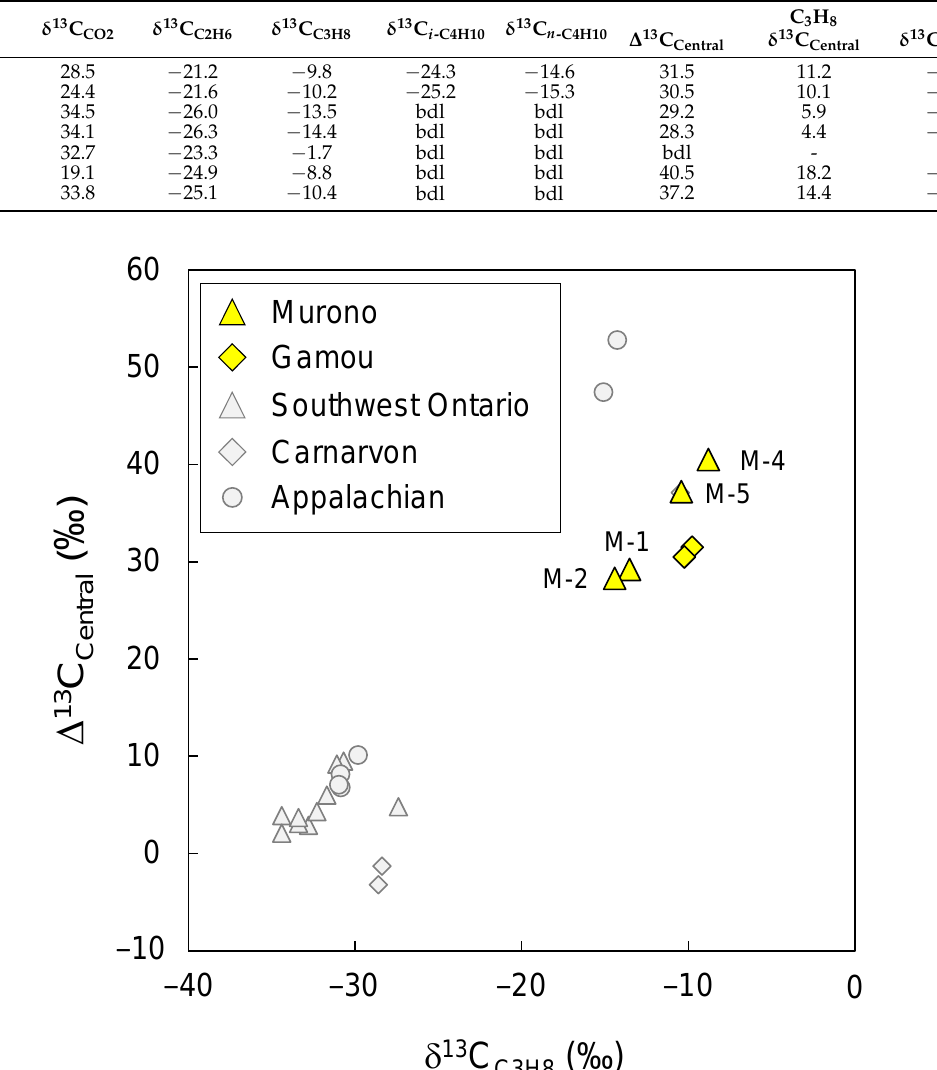
Table 2. Bulk and position-specific isotope composition of hydrocarbons and CO 2 from Murono (M) and Gamou (G) samples. “bdl” = below detection limit.